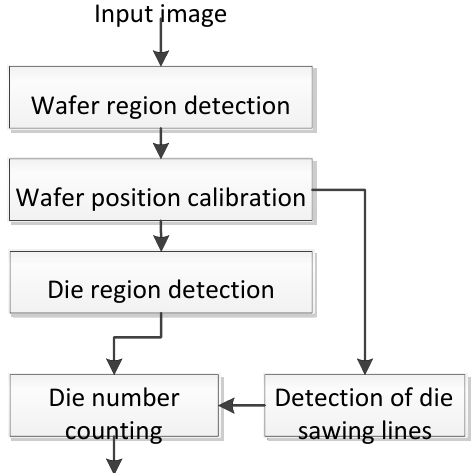
Figure 1. The system flowchart of the proposed